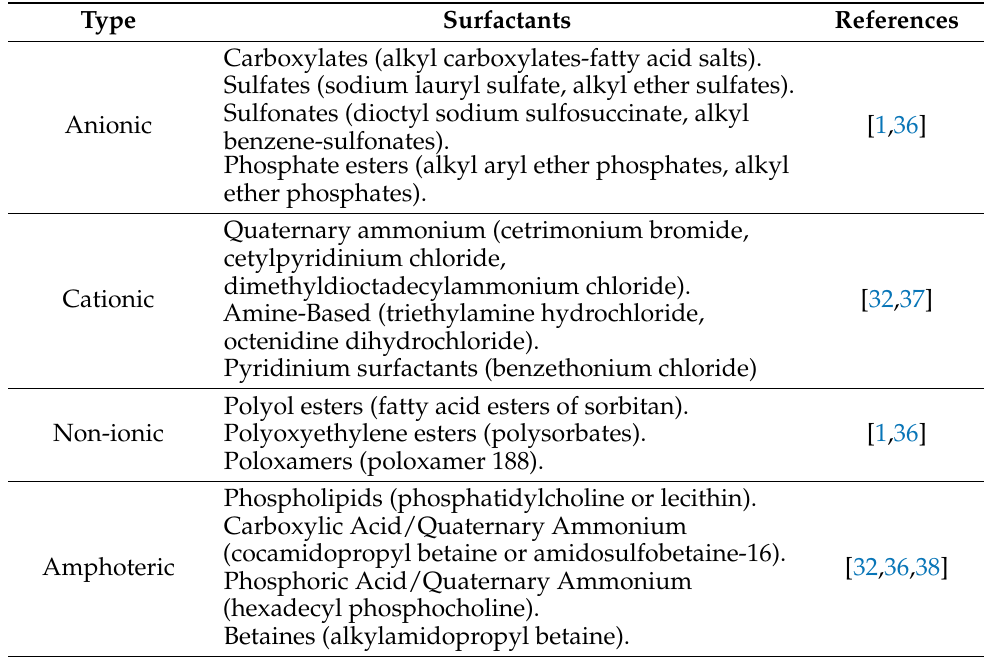
Table 1. Examples of surfactants used in pharmaceutical